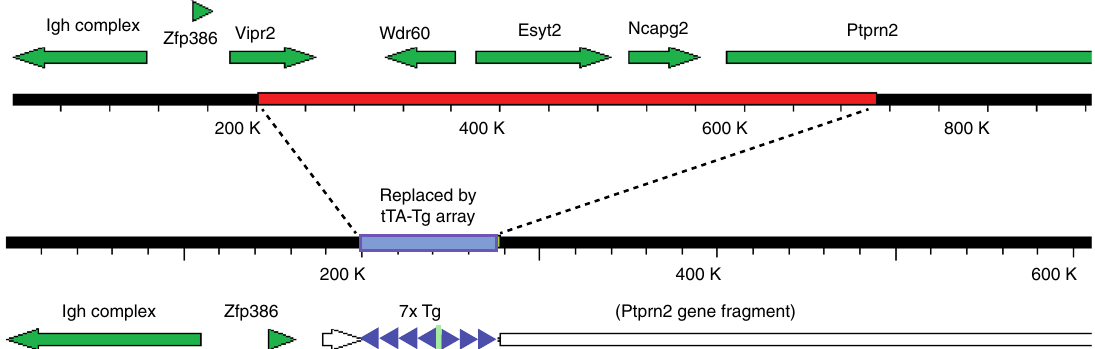
Fig. 5 The tTA transgene array in rTg4510 and rT2/T2 mice disrupts genes on chromosome 12. Diagram of the uninterrupted chromosomal region and its disruption by the tTA-TgINDEL mutation. Tg, transgenes are blue triangles, cloning vector in inversion point of Tg array is a green line, uninterrupted genes are fi lled arrows, and partially deleted gene fragments are white